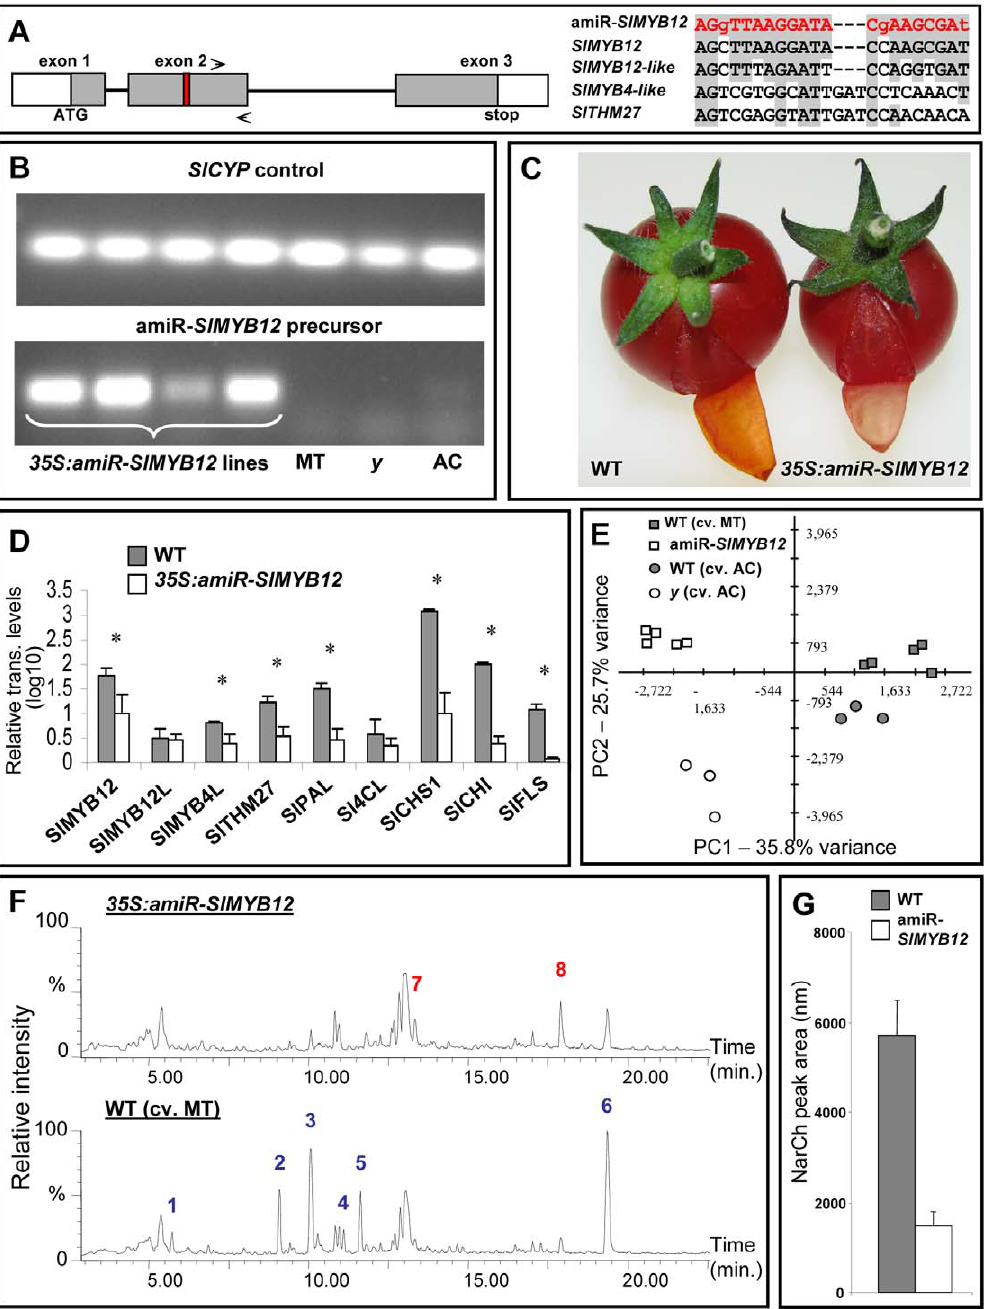
Figure 9. The transgenic amiR- SlMYB12 lines exhibit a y -like phenotype. (A) Red box indicates the location of the amiR- SlMYB12 target sequence on the SlMYB12 gene, arrows indicate the position of RT–PCR primers, andthe sequence alignment on the right demonstrates thespecificityof this artificial microRNA. (B) Expression of the amiR- SlMYB12 precursor in samples extracted from leaves of 35S:amiR-SlMYB12 -transgenic lines and non-transgenic controls. (C) Fruit of 35S:amiR-SlMYB12 -transgenic lines display colorless peel. (D) RT–PCR relative expression analysis of phenylpropanoid/flavonoid-related regulators and structural genes in fruit peel of wt and 35S:amiR-SlMYB12- transgenic lines. Indicated by asterisks are significantly reduced levels analyzed by Student’s t-test (n=3; P , 0.05; bars indicate standard errors). (E) PCA of metabolic profiles obtained by UPLC-QTOF-MS analysis carried out on peel samples of wt cv. AC and cv. MT, y mutant and an amiR- SlMYB12 -transgenic line at the red stage of fruit development. Analysis was performed with the TMEV program using normalized and log-transformed data. (F) Total ion chromatograms (TICs) of wt (cv. MT) and 35S:amiR-SlMYB12 peels at the red stage of fruit development, acquired in the negative mode using UPLC-QTOF-MS (in relative intensity, 100% corresponds to 6.14 6 10 4 counts). The putative identity of the differential compounds is: 1 - quercetin-dihexose-deoxyhexose, 2 - quercetin-hexose-deoxyhexose-pentose, 3 - quercetin-rutinoside (rutin), 4 - phloretin-di-C-hexose, 5 - kaempferol-glucose-rhamnose, 6 - naringenin chalcone, 7 - dicaffeoylquinic acid III, 8 - tricaffeoylquinic acid. Red and blue numbers indicate metabolites that showed elevated or reduced levels in the transgene samples in comparison to those of their corresponding wt, respectively. (G) Relative levels of NarCh in cv. MT and 35S : amiR-SlMYB12 , expressed as chromatographic peak areas, calculated for m/z 271.06 Da (n=5).